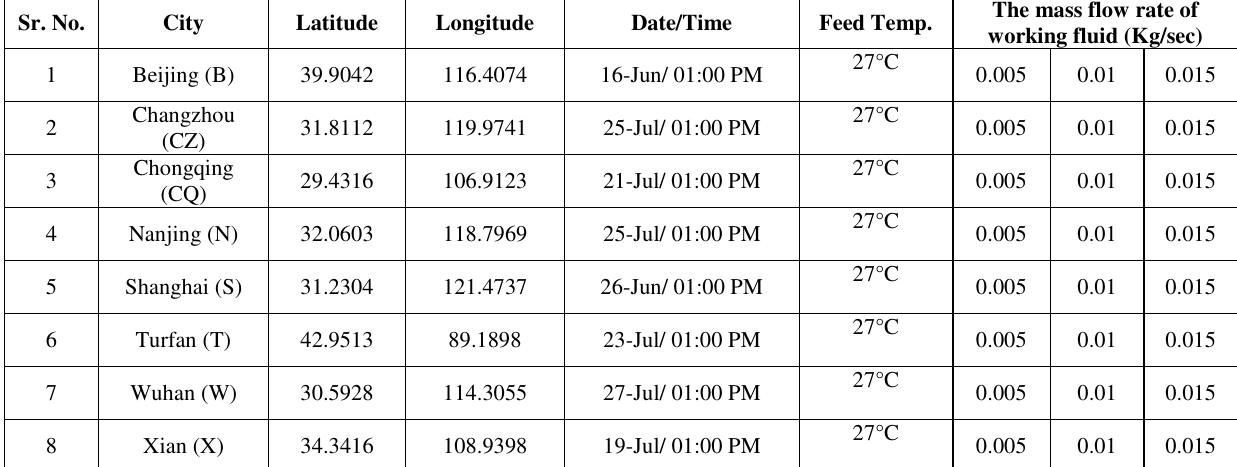
Table 3: Input conditions for various simulated cases